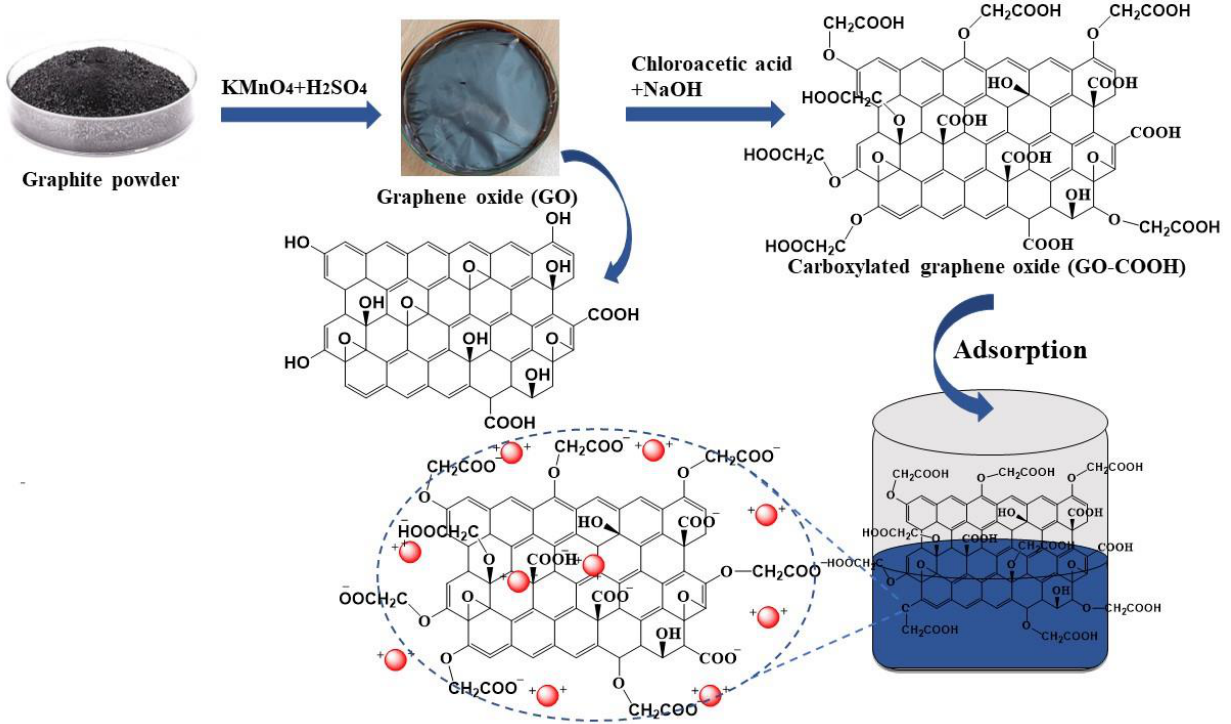
Figure 1. Schematic representation of synthesis of GO, its modification with chloroacetic acid and adsorption of Pb and Cr.